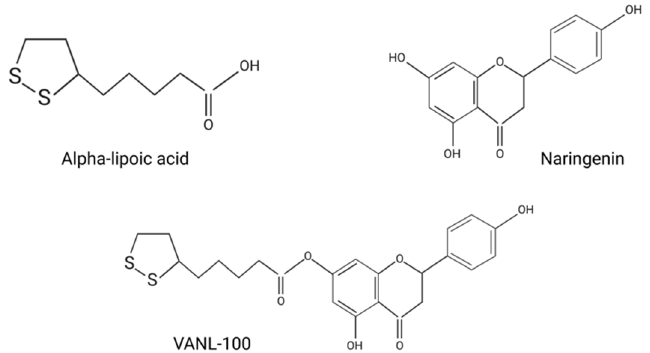
Figure 1. Chemical structures of alpha-lipoic acid (ALA), naringenin (NAR), and